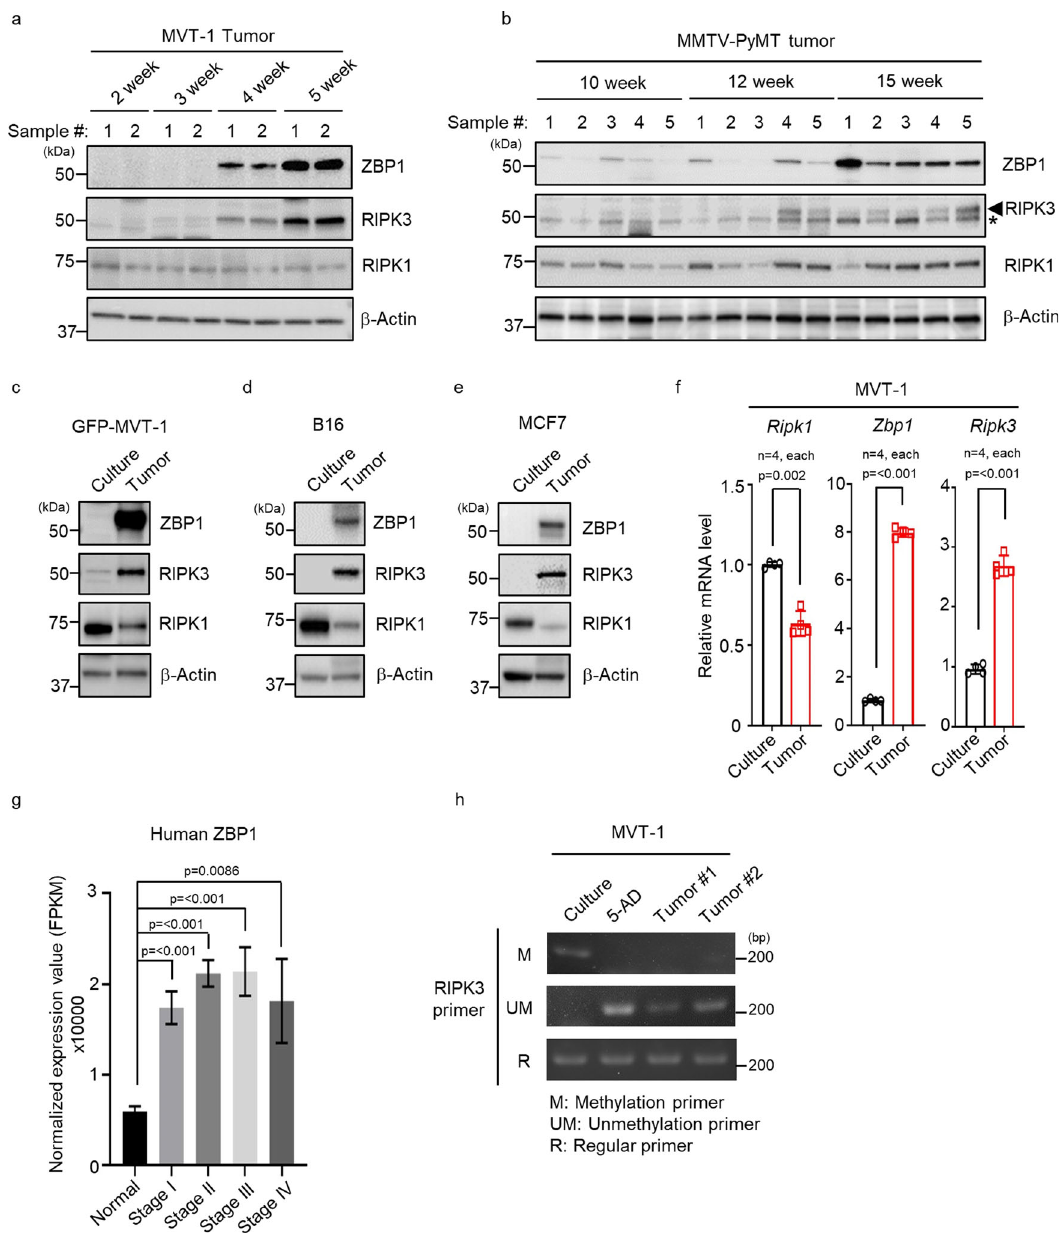
Fig. 2 ZBP1 is highly increased in late stage of mouse and human tumors. a – e Western blotting analysis representative of three independent experiments. a MVT-1 tumors were collected at 2 – 5 weeks post-implantation and tumor cell lysates were analyzed by western blotting with the indicated antibodies. b MMTV-PyMT breast tumors were collected at 10 – 15 weeks and tumor cell lysates were analyzed by western blotting with the indicated antibodies (*, non-speci fi c band). c GFP-MVT-1 tumor cells were collected at 5-week post implantation and the lysates were analyzed by western blotting with the indicated antibodies. d C57BL/6 J mice implanted with syngeneic B16 mouse melanoma cells and tumor cells were collected at 2-weeks post- implantation. Western blot analysis of cultured B16 cell lysates or B16 tumor cell lysates was done using the indicated antibodies. e BALB/c-nu/nu mice implanted with MCF7 human breast cancer cells and tumor cells were collected at 8-weeks post-implantation. Western blot analysis of cultured MCF7 cell lysates or MCF7 tumor cell lysates was done using the indicated antibodies. To be comparable to the late stage necrotic tumors, the tumors from these models in d and e were collected when they approached 1500 – 2000mm 3 in volume and had tumor necrosis. f Quantitative real-time PCR analysis of the relative expression of Ripk1 or Zbp1 or Ripk3 mRNA from cultured MVT-1 cells or MVT-1 tumor cells isolated from the mice implanted with MVT-1 cells